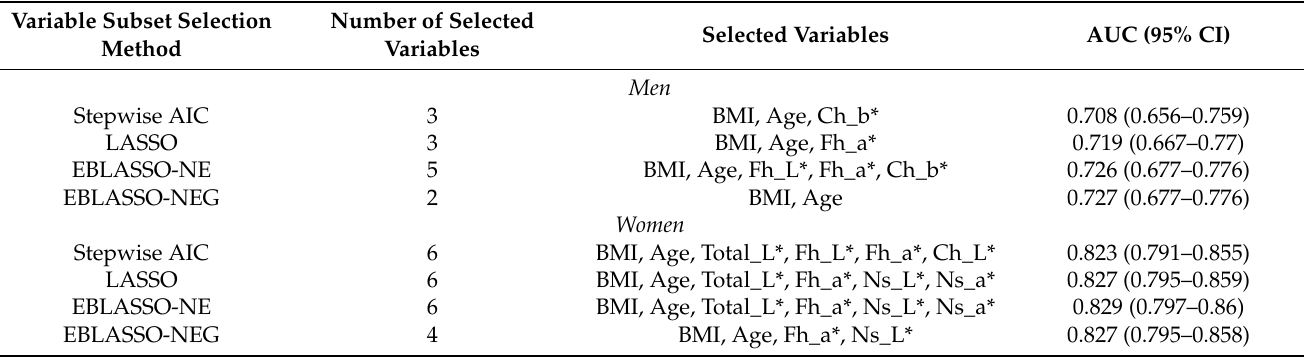
Table 5. The variables selected by Stepwise AIC, LASSO, EBLASSO-NE, and EBLASSO-NEG methods in logistic regression and the powers of the